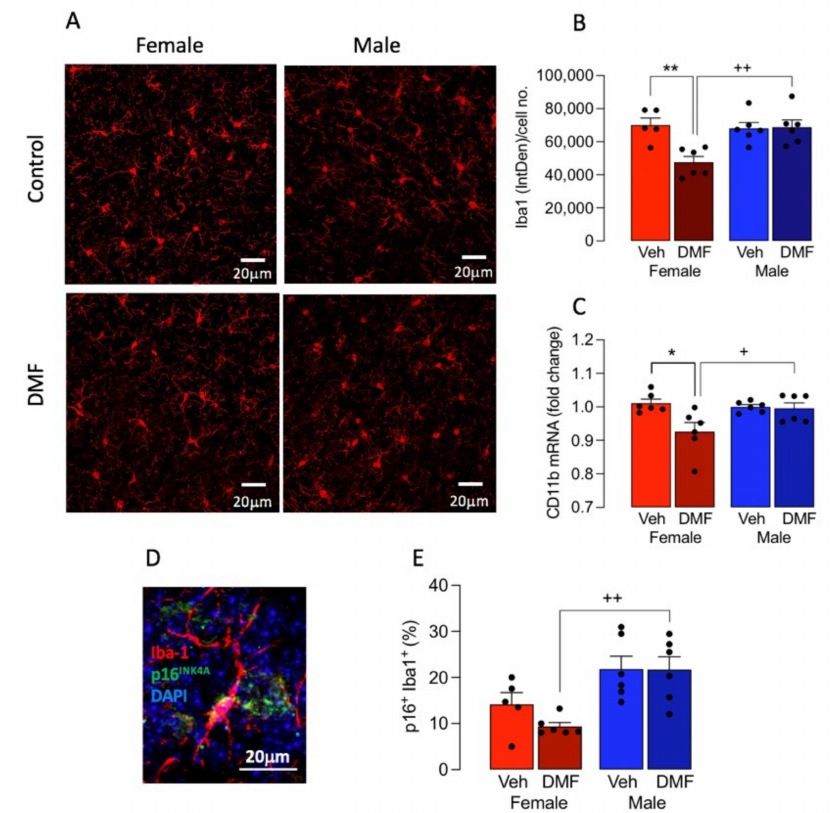
Figure 1. DMF decreased microglial activation in female mice. ( A ) Iba1 staining was performed using immunohistochemistry in tissue sections from DMF- and vehicle-treated male and female mice. The sample immunograph suggests that DMF decreases Iba1 immunoreactivity in sections prepared from female mice. Scale bar = 20 µ m. ( B ) Analysis of the mean data revealed a significant treatment x sex interaction ( p < 0.01; 2-way ANOVA) and post-hoc analysis indicated that Iba1 immunoreactivity was significantly decreased in sections from DMF-treated, compared with vehicle-treated control, female mice (* p < 0.05) and compared with DMF-treated male mice ( ++ p < 0.01). Data are represented as means ± SEM ( n = 5 or 6). ( C ) Analysis of mRNA expression of CD11b in tissue prepared from